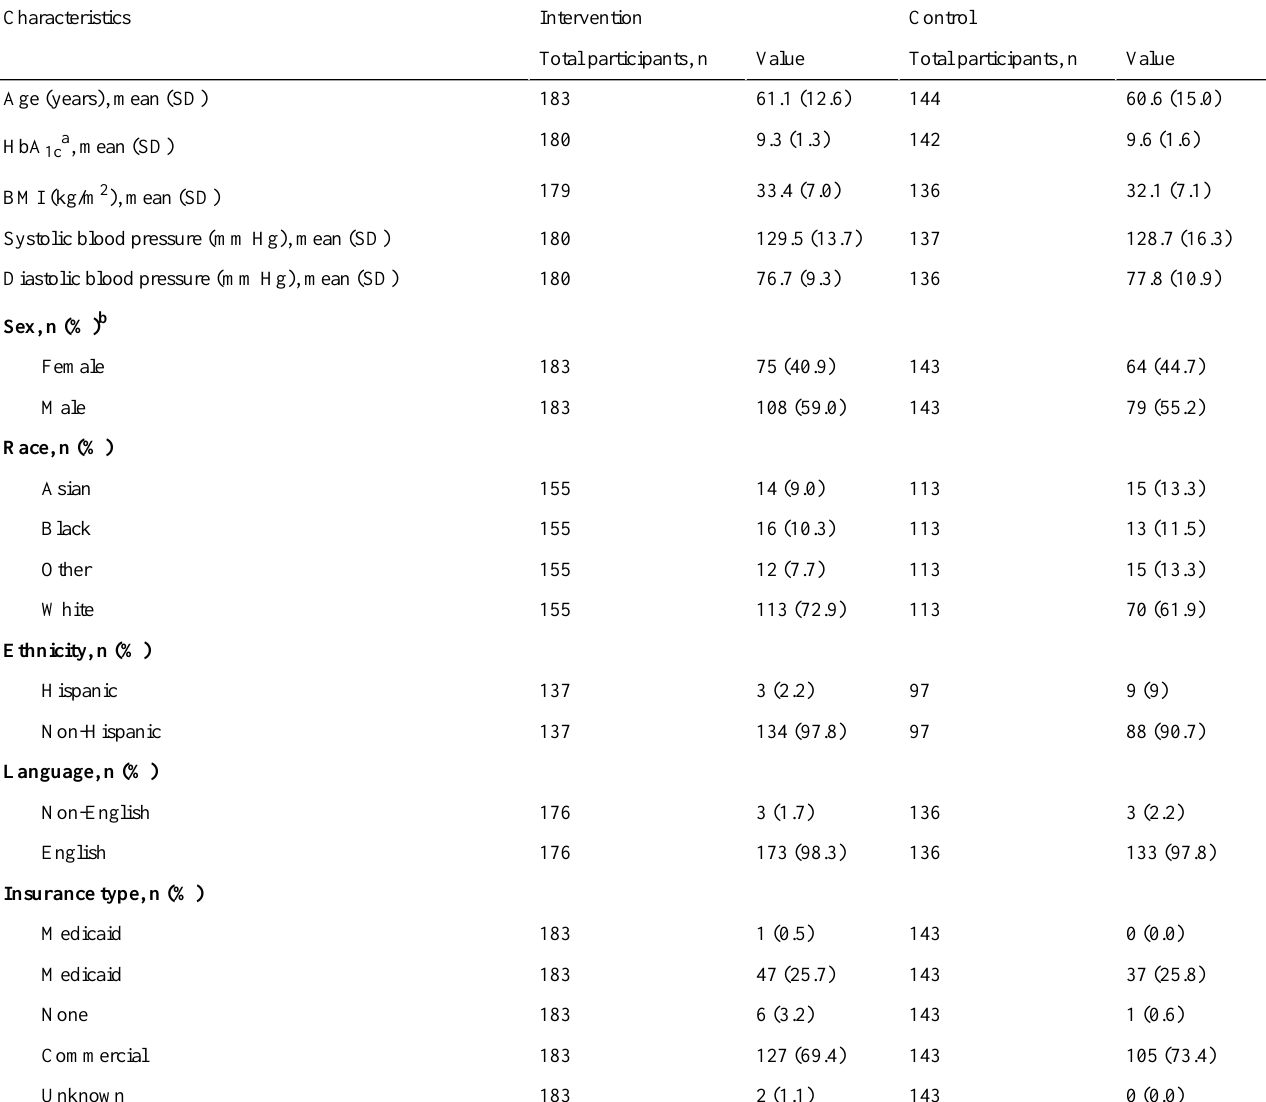
Table 4. Patient demographics at baseline.